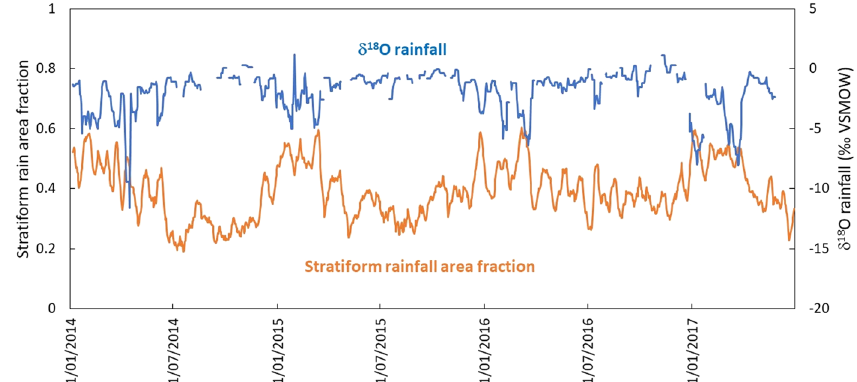
Figure 4. Cairns time series of 10-day moving average of rainfall δ 18 O values and stratiform rainfall area fractions (5° × 5° box centred on Cairns) from January 1, 2014 to July 1,